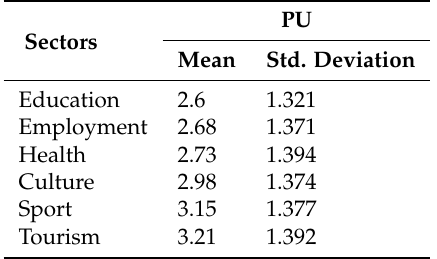
Table A10. Ranking of information sectors by mean score of PU.